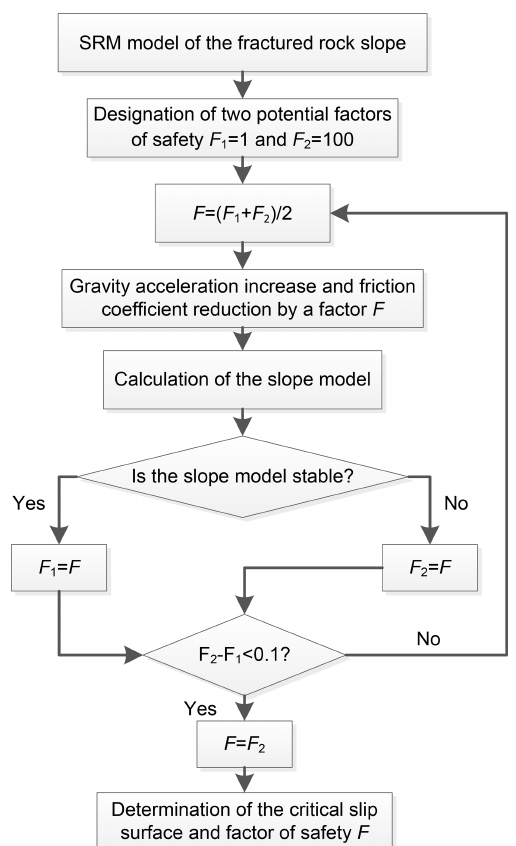
Figure 7. Programme flow chart for the slope stability analysis.